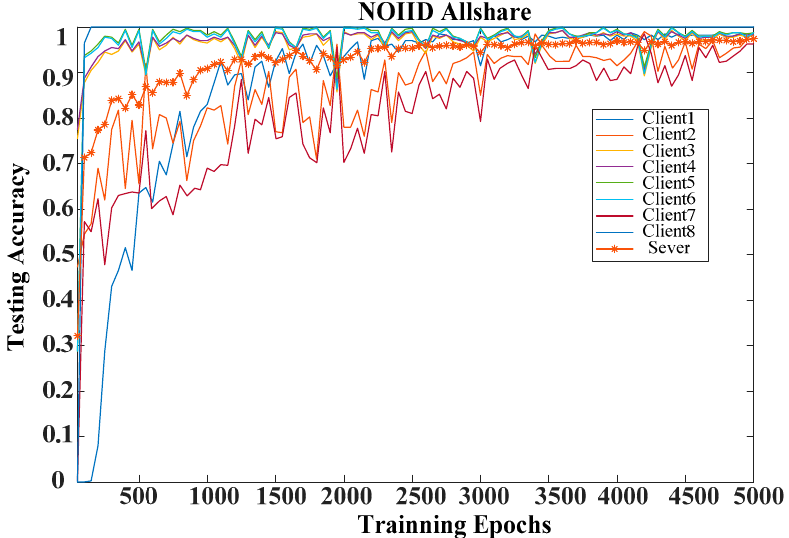
Figure 14. Accuracy rates trend of i-MFN under NOIID data distribution with network parameters federated.